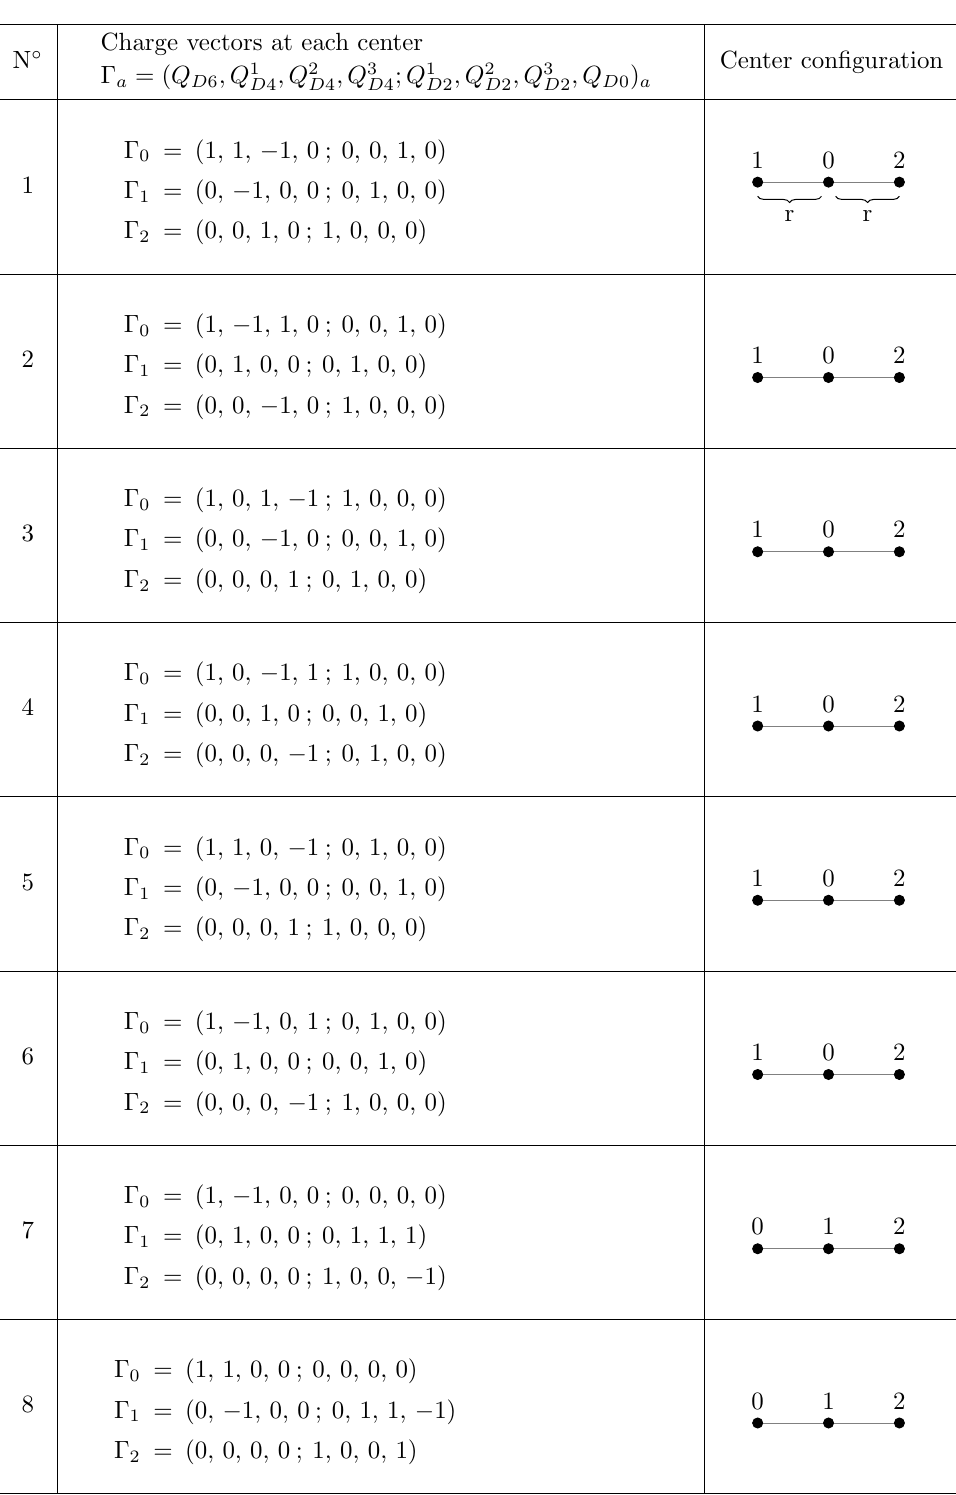
; Q 2 ; Q 3 D 4 D 4 D 4